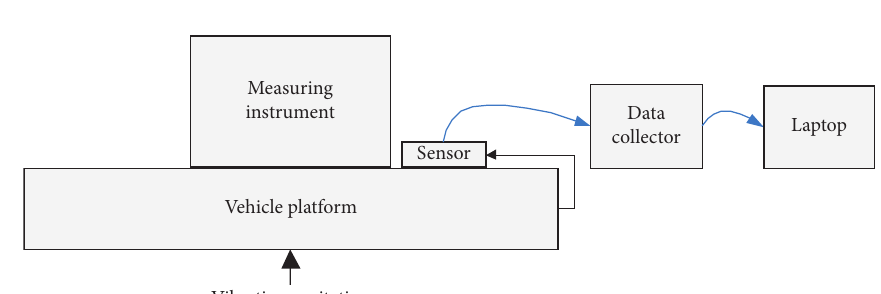
Figure 7: IMFs of NSEEMD on simulation signal.